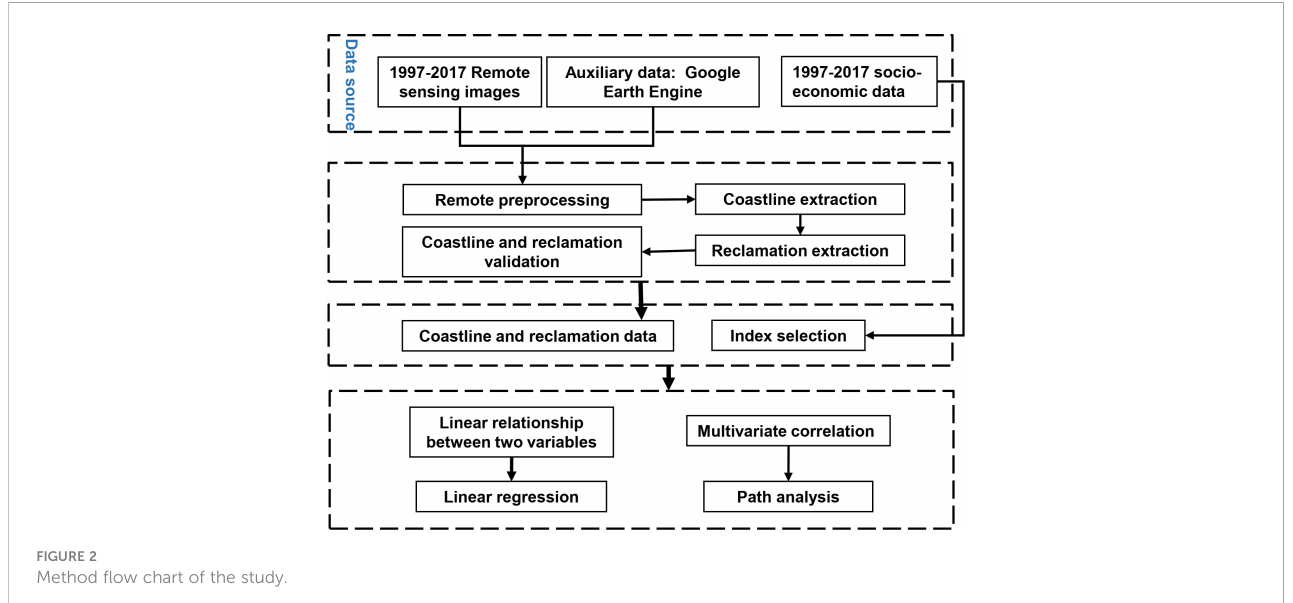
FIGURE 2 Method fl ow chart of the study.